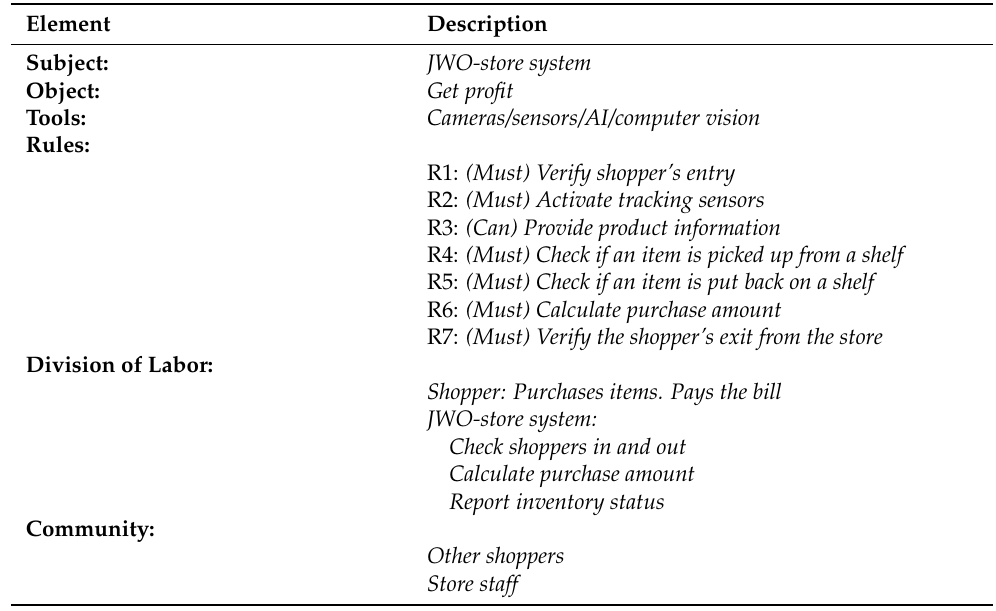
Store staff Table 2. Key Activity System for the JWO-Store System. Table 2. Key Activity System for the JWO-Store System. Element Description Element Description